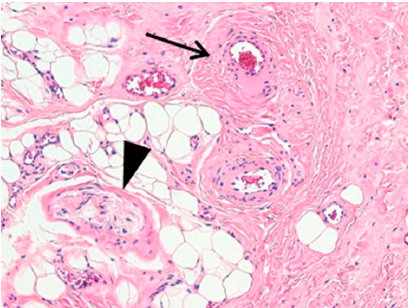
Figure 1. (Hematoxylin-Eosin, original magnification 100×). Different fields of the same slide showing connective and adipose tissue intermingled with small blood vessels (large arrow)